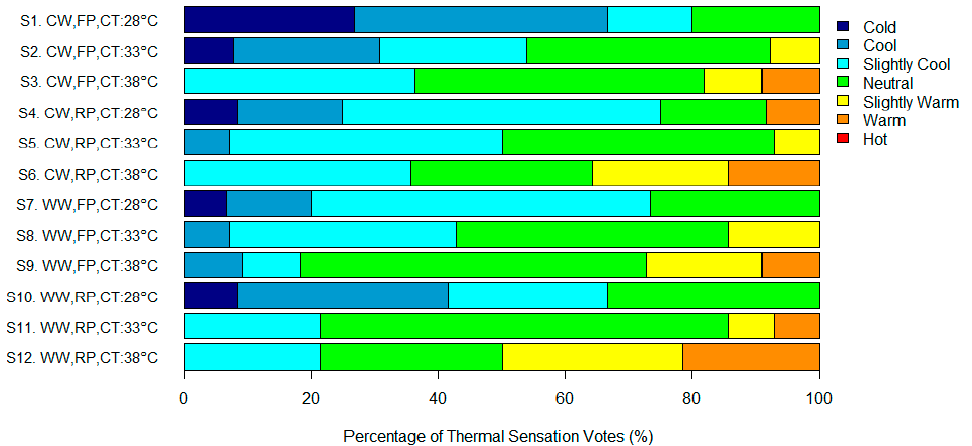
Figure 6. Percentage of overall thermal sensation votes divided into 7 scales, from cold to warm, in response to 12 different experimental scenarios. S1–S12 are the twelve scenarios presented in Figure 2 and Table 3. CW and WW denote cool and warm window; FP and RP stand for the front and rear positions; and CT is the ceiling surface temperature.